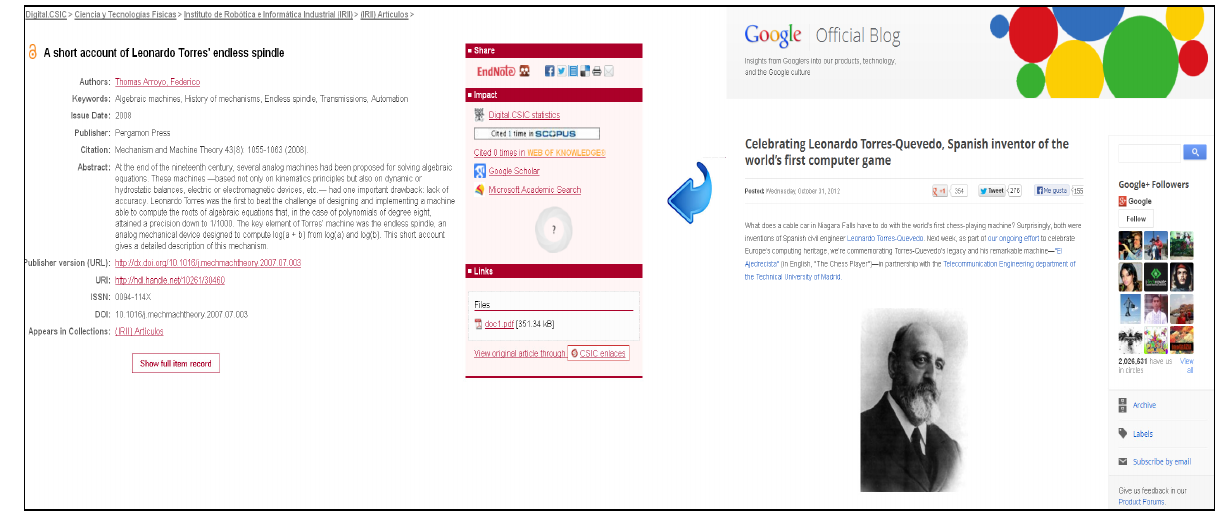
Figure 9. Article A short account of Leonardo Torres’ endless spindle [43]